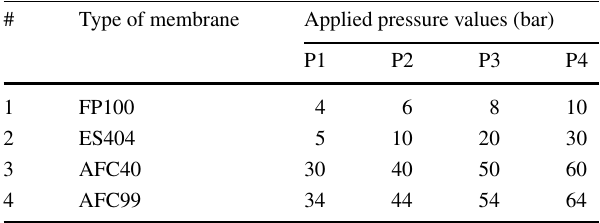
Table 8 Different applied pressure values for the four commercial membrane